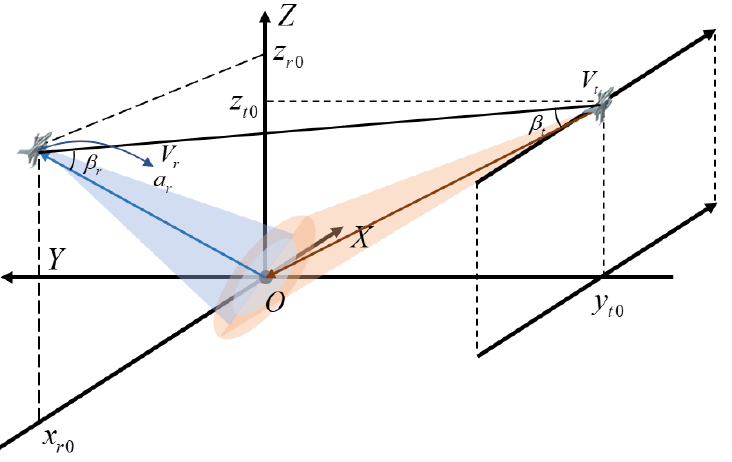
Figure 5. Bistatic forward-looking SAR for a high-speed mobile